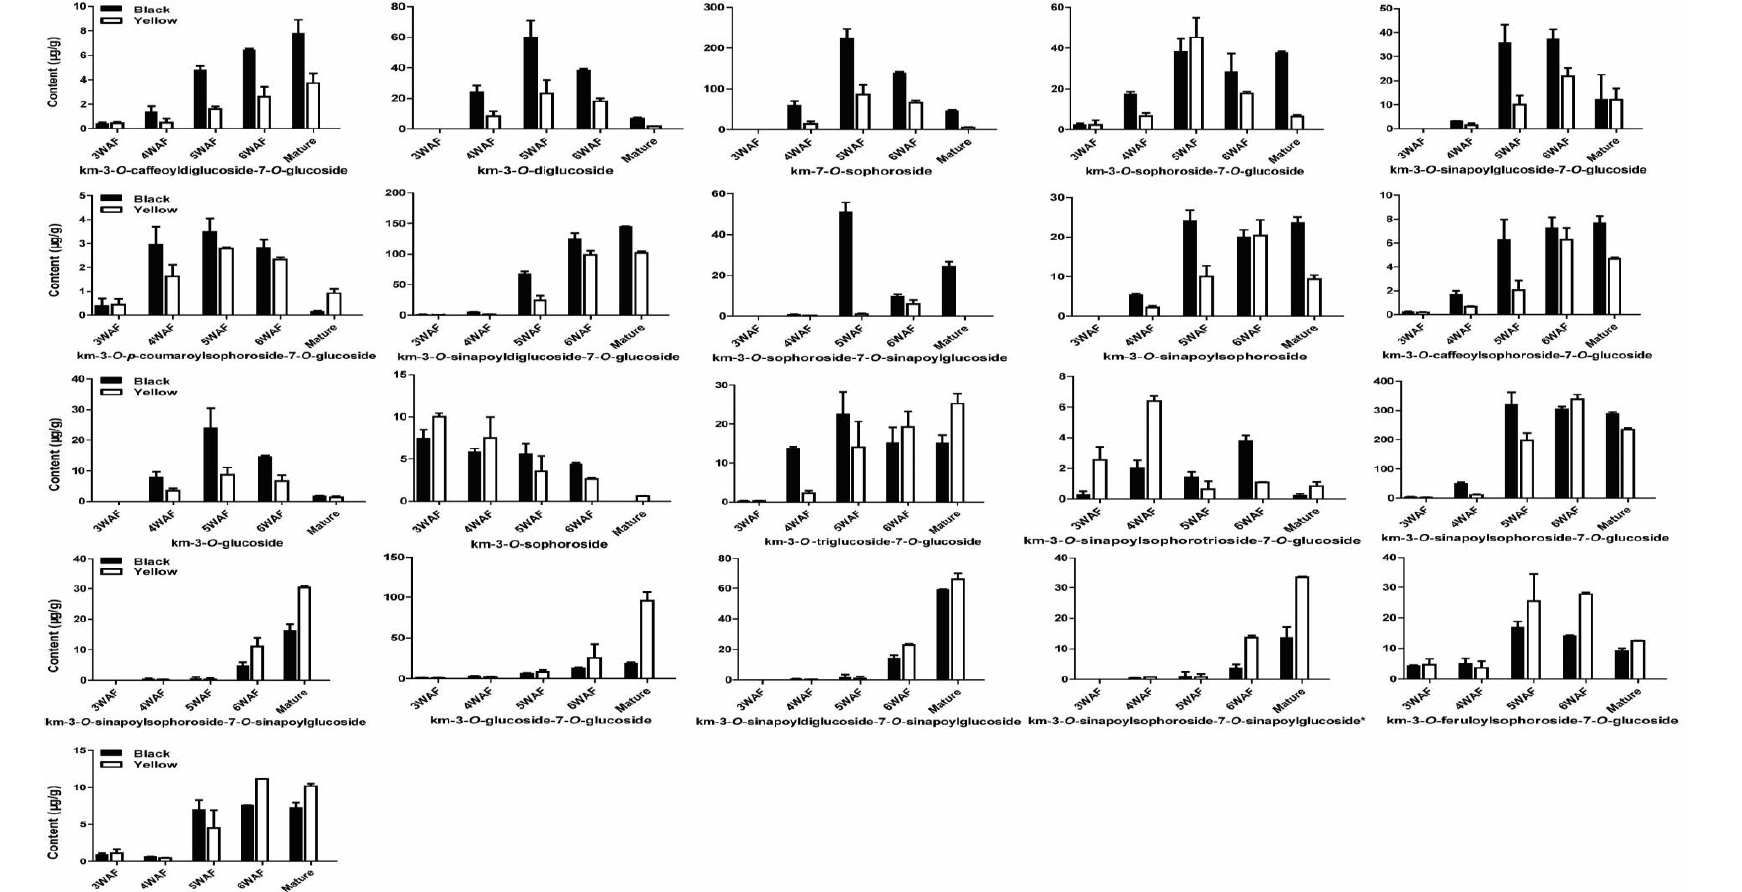
Figure 4. Accumulation pattern of kaempferols in yellow and black rapeseed. km, kaempferol; WAF, week after flowering.